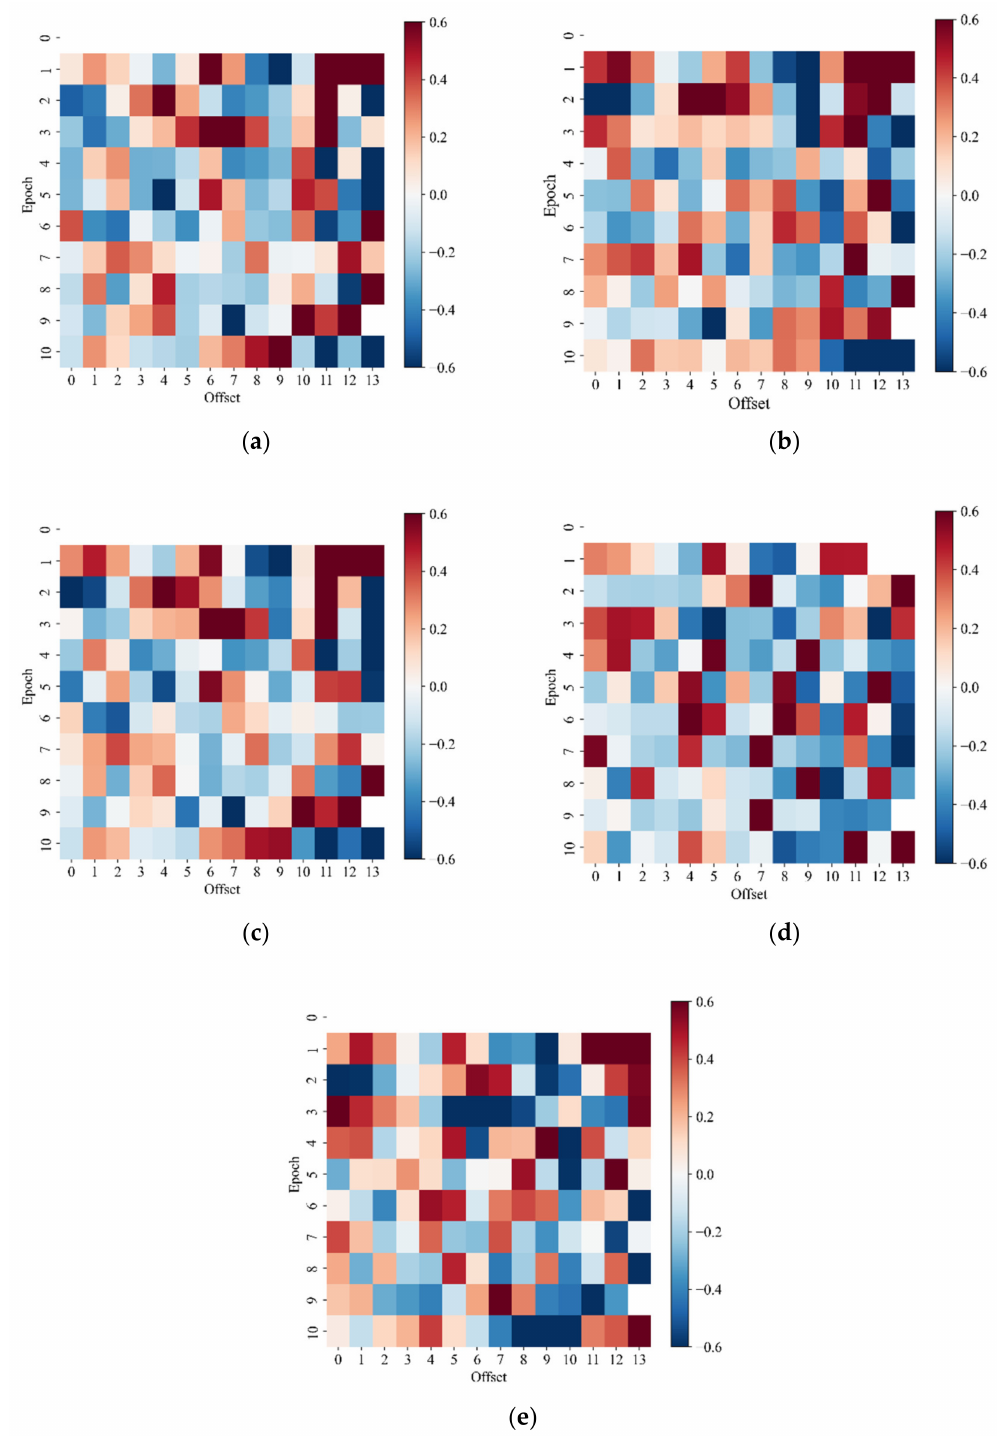
Figure 5. WTLCC charts between the cumulative number of distress initiations (No_DIS_INI) and meteorological variables. ( a ) WTLCC between No_DIS_INI and daily maximum temperature; ( b ) WTLCC between No_DIS_INI and daily minimum temperature; ( c ) WTLCC between No_DIS_INI and daily average temperature; ( d ) WTLCC between No_DIS_INI and daily total precipitation; ( e ) WTLCC between No_DIS_INI and relative